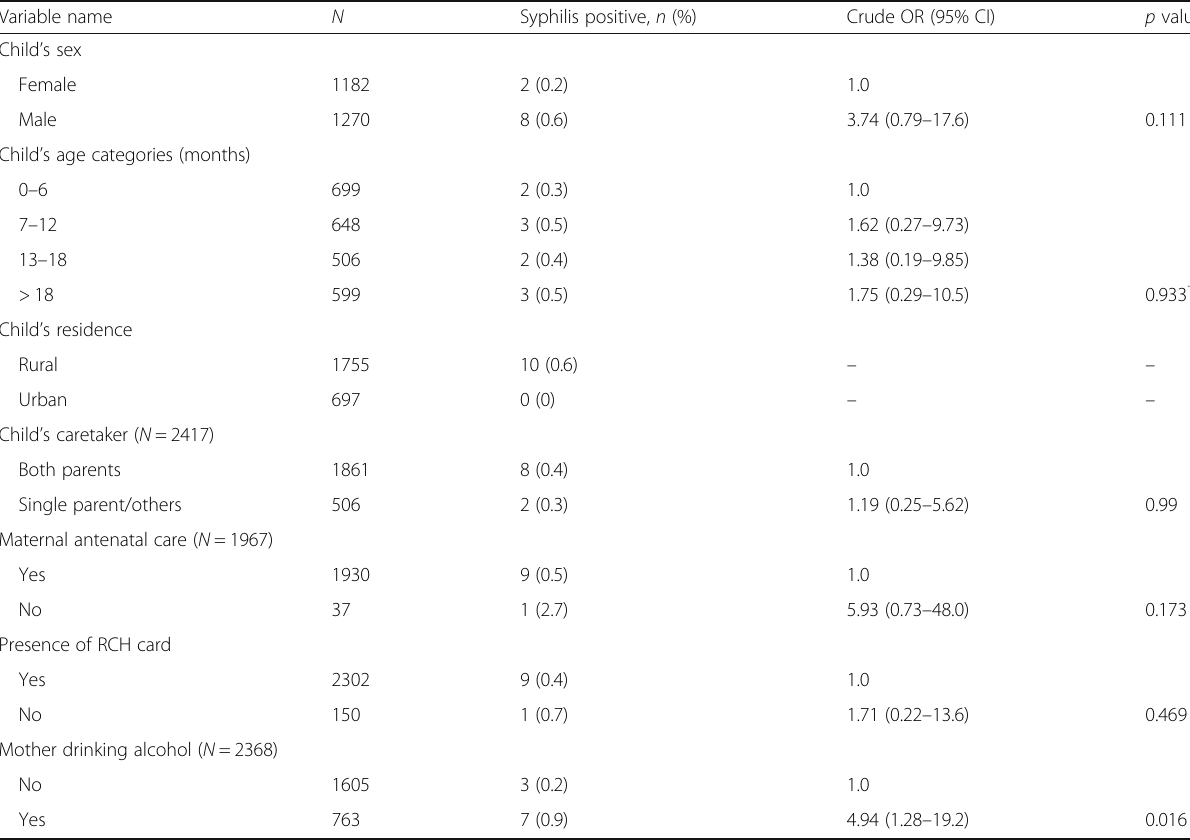
Table 4 Distribution of syphilis by demographic characteristics in children of 0 – 36 months in Kilimanjaro region, N =